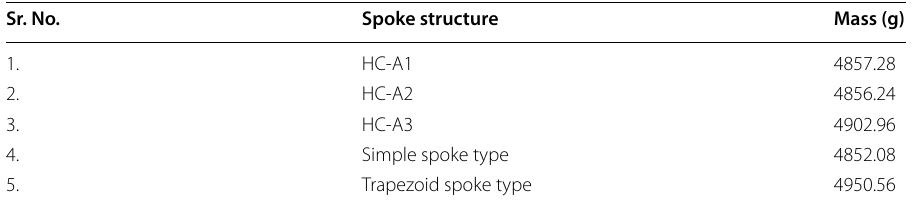
Table 2 Mass values of different polyurethane spoke structures [10, 16] Sr. No.